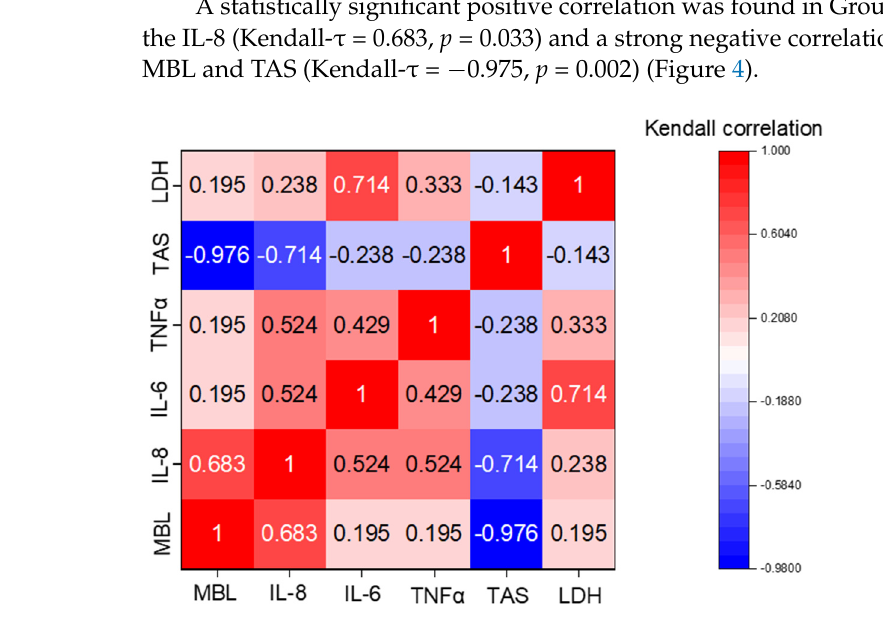
Table 4. Peri-implant marginal bone loss (MBL) measured between baseline (same day as saliva collection) and one-year follow-up. mm